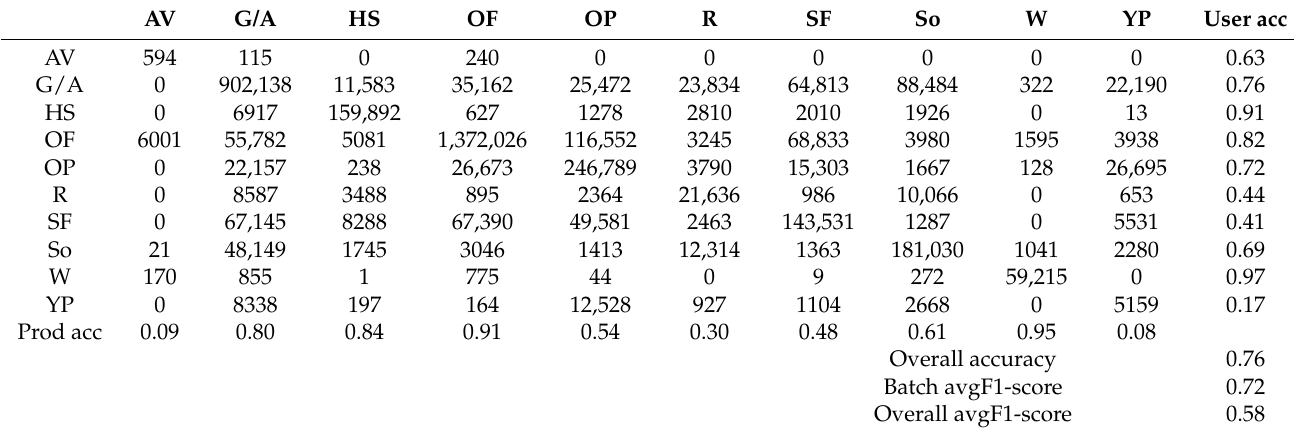
Table A1. Confusion matrix for the validation set using the MS + SAR U-net. Rows show predicted classes while column, ground truth classes. LULC abbreviations: AV, aquatic vegetation; G/A, grasslands/agriculture; HS, human settlements; OF, old-growth forests; OP, old-growth plantations; R, roads; SF, secondary forest; So, soil, W, water; YP, young plantations. User acc stands for user’s accuracy, while Prod acc for producer’s